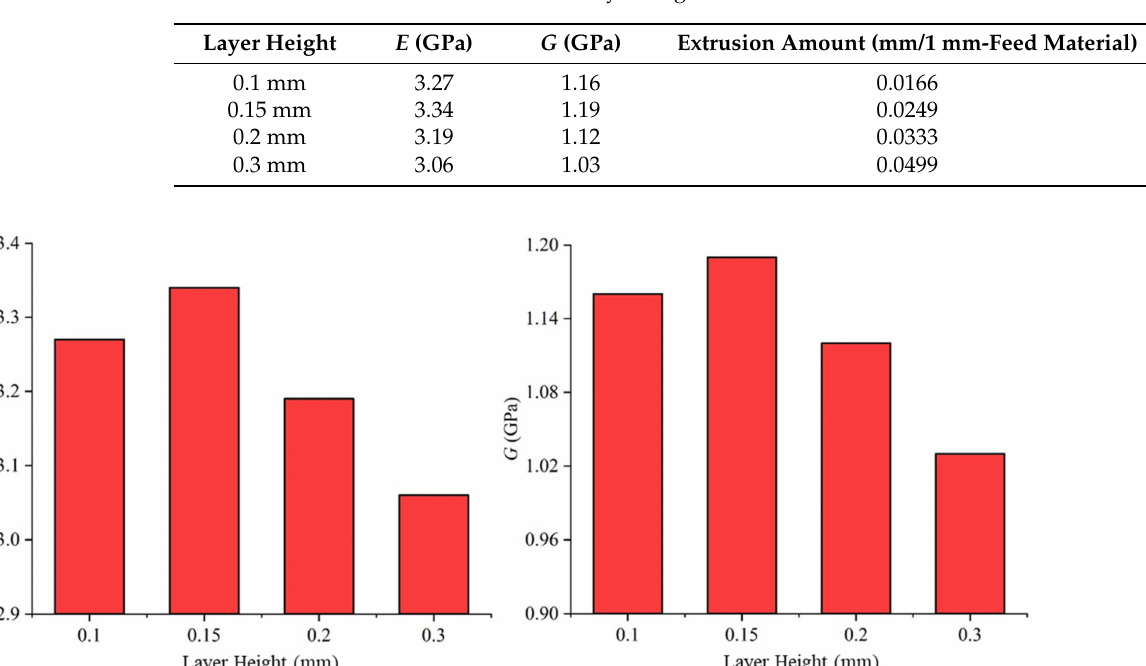
Table 6. Material constants with different layer heights.